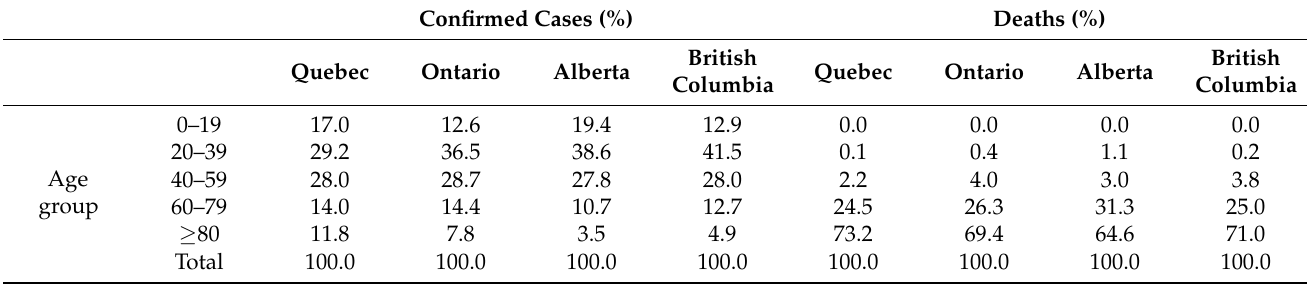
Table 4. Distribution of COVID-19 cases and deaths in Canada by age group and province (as of 15 December 2020). Confirmed Cases